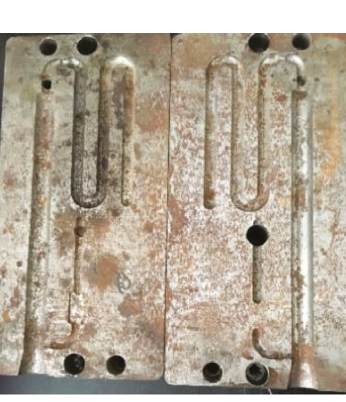
Figure 2: The main cavity mold.